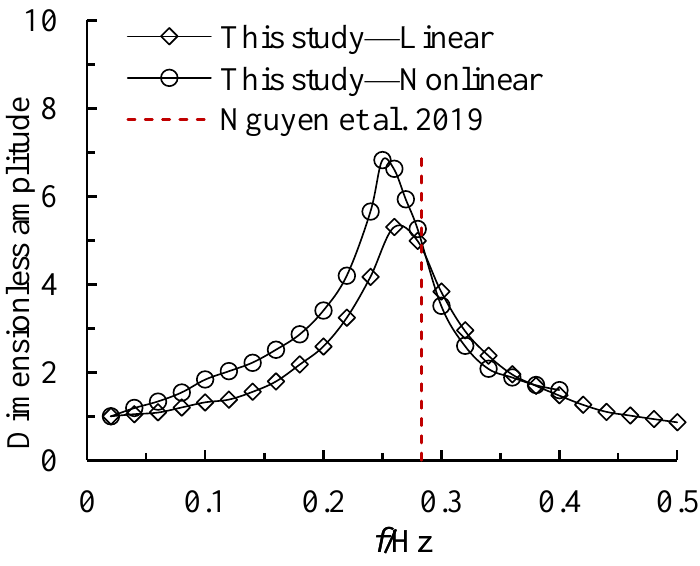
Figure 10. Comparison of the resonant frequency of the OWTs [24].